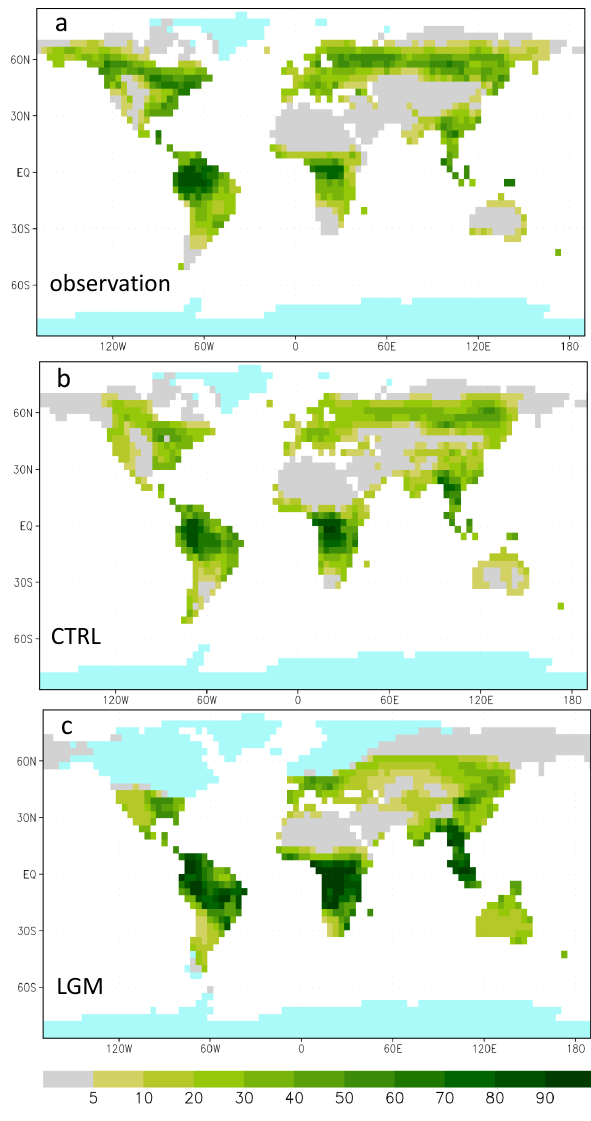
Fig. 1. (a) Present-day tree and shrub cover based on MODIS data by Hansen et al. (2007) averaged on the MPI-ESM grid (Figure taken from Brovkin et al., 2009). (b) Simulated tree and shrub cover in the control simulation CTRL (modified to account for historical deforestation). (c) Simulated tree and shrub cover in the LGM sim-